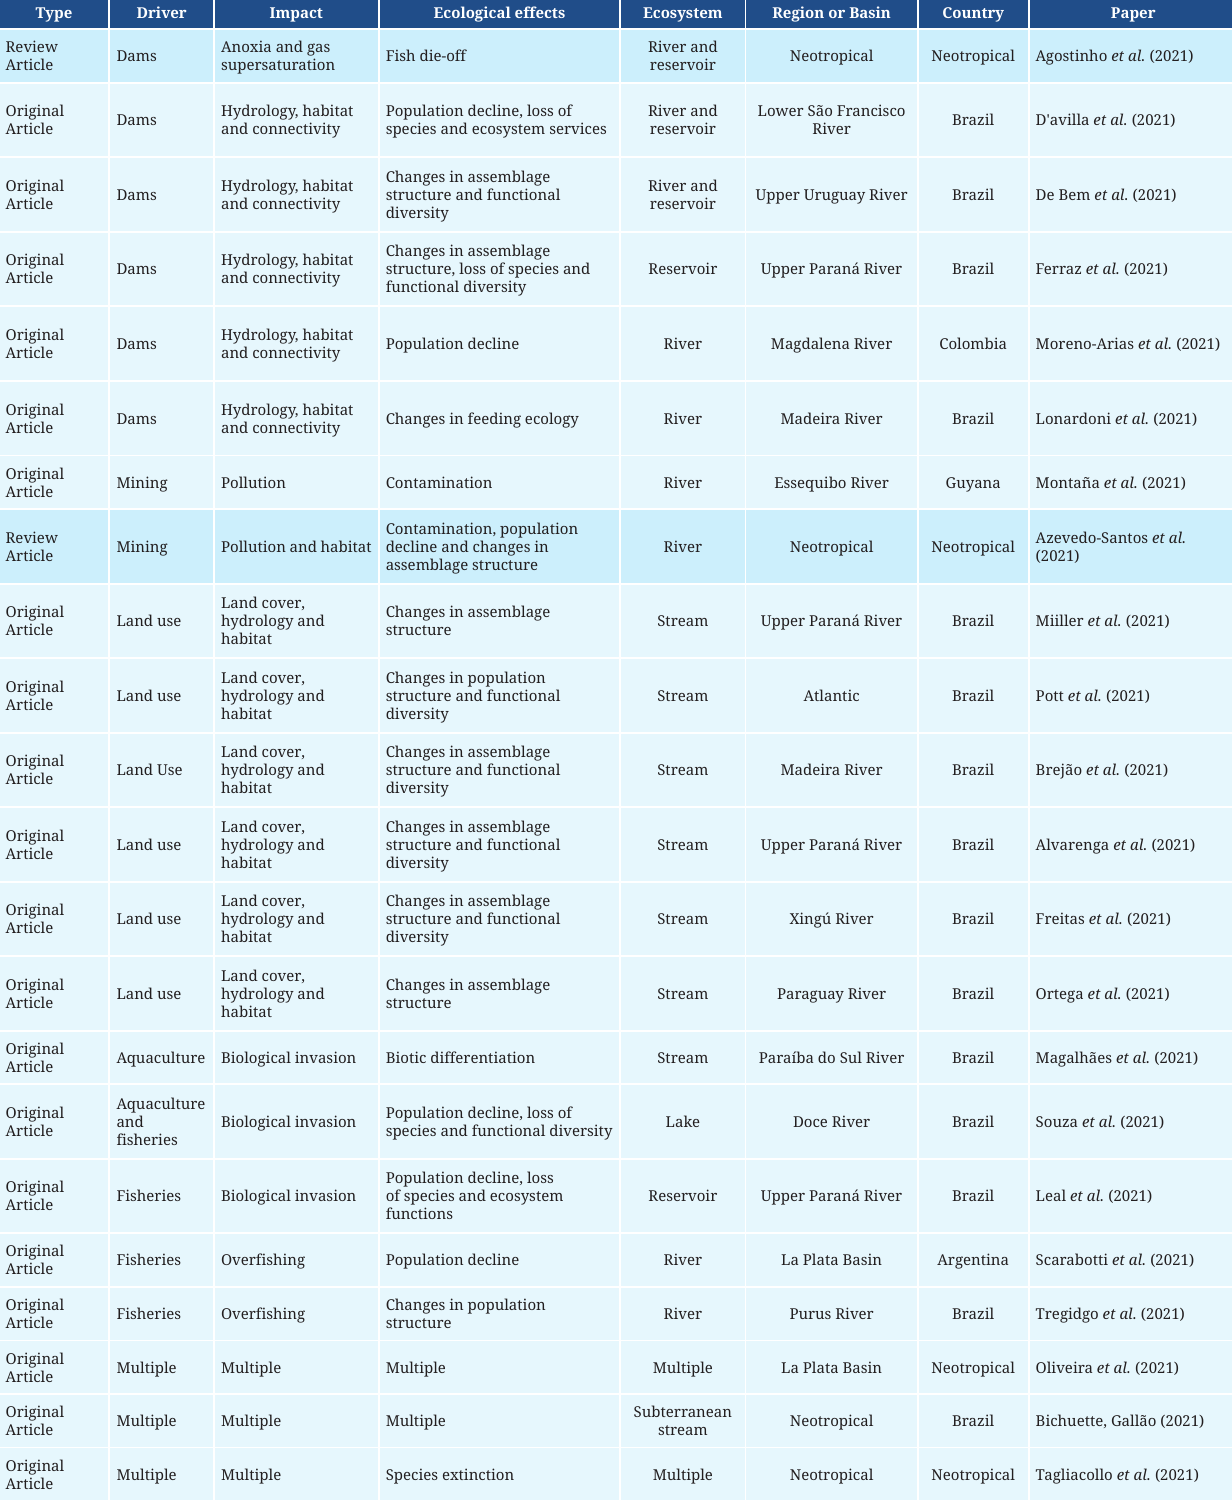
TABLE 1 | Studies included in this Special Issue (Human impacts and the loss of Neotropical freshwater fish diversity) of Neotropical Ichthyology, depicting topics addressed by each study. Review articles are highlighted in a darker blue